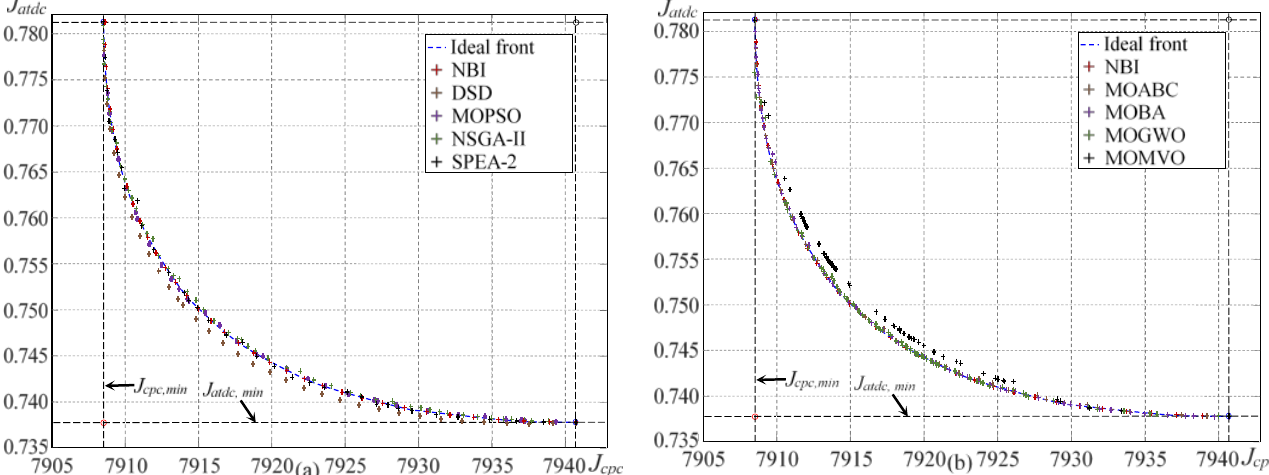
Figure 7. Pareto fronts of all algorithms. ( a ) NBI, DSD, MOPSO, NSGA-II, and SPEA-2. ( b ) MOABC, ABC, MOBA, MOGWO, and MOMVO, where NBI is included as a reference. © [2020] IEEE. Reprinted, with permission, from [10].